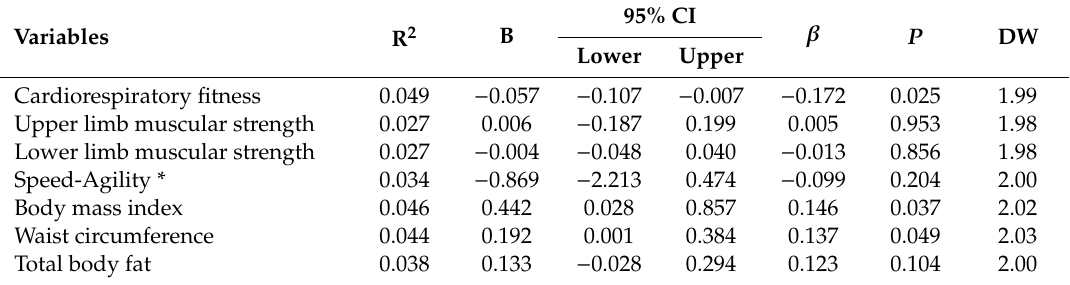
Table 2. Linear regression analyses of health-related physical fitness components with self-rated risk of depression.